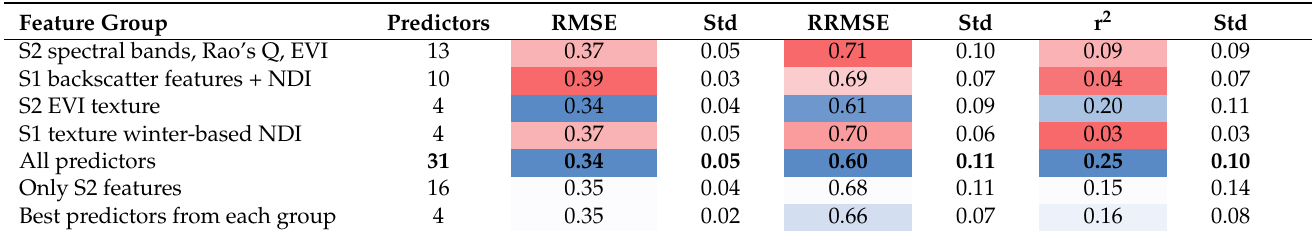
Table 4. Model accuracy metrics (root mean squared error, relative root mean squared error, co- efficient of determination) of tree species diversity models. The table with heatmap (red = low accuracy, blue = high accuracy) shows the median and standard deviation values summarized over ten model iterations.